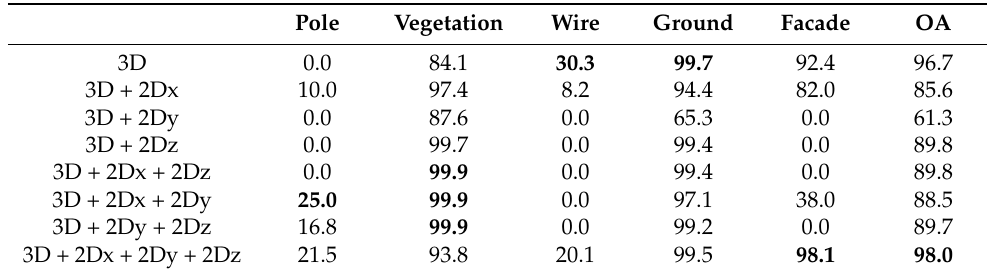
Table 5. Multi-level features accuracy of Oakland dataset